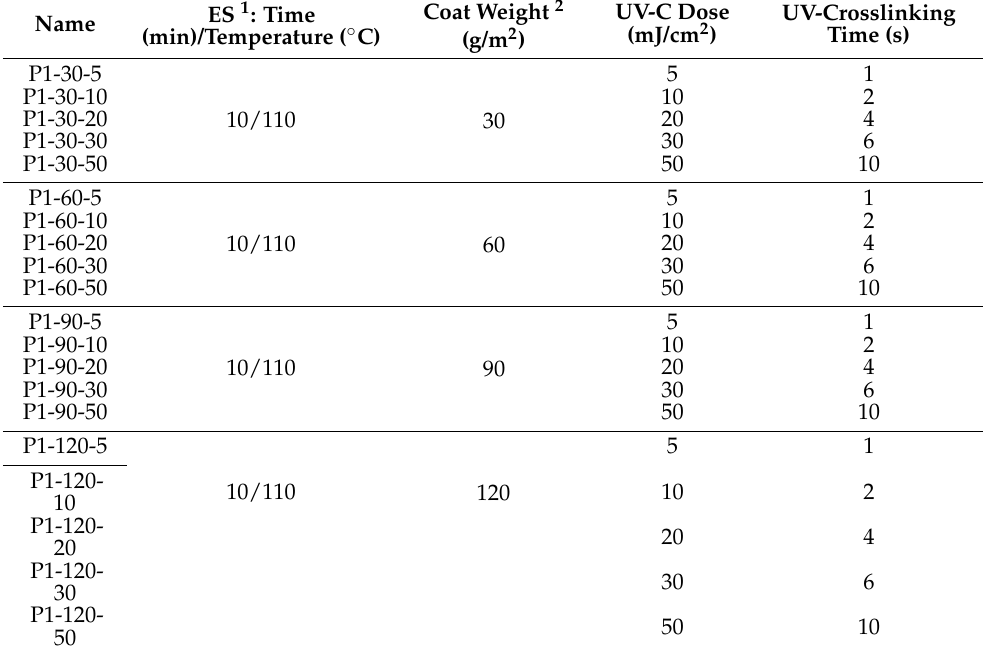
Figure 2. The wavelength range of radiation emitted by the UV lamp used. Table 3. The conditions of preparation of adhesive films for P1 synthesis. The films from the remaining syntheses were made